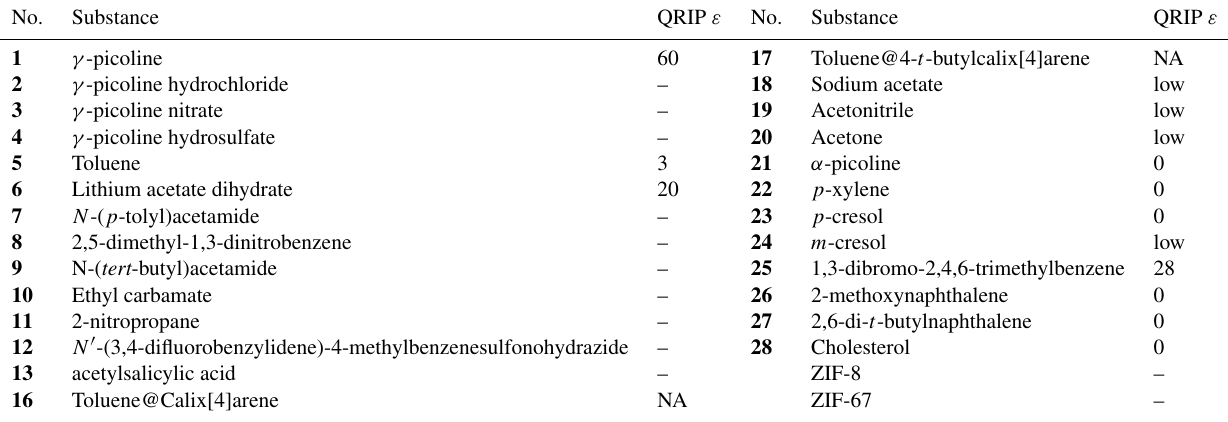
Table 1. Overview of all substances which were experimentally or theoretically (crystal structure analysis) examined in this study. The reference numbers are bold to indicate a